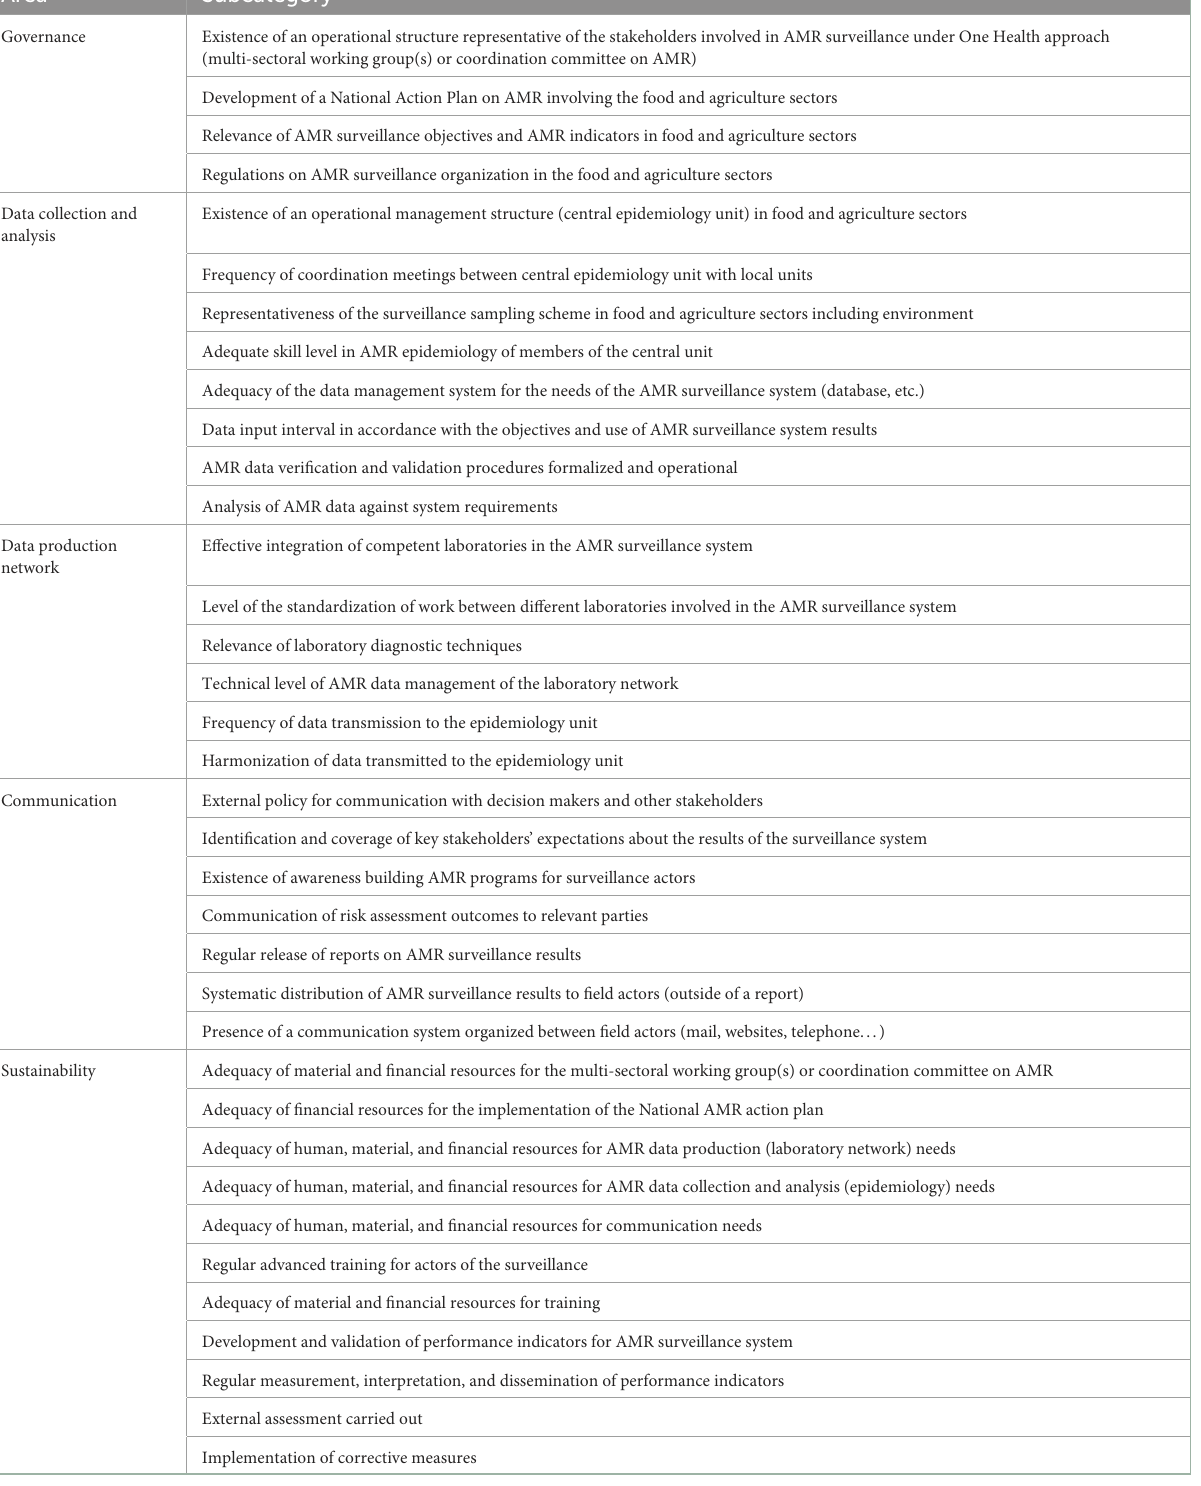
TABLE 1 Information collected in FAO-ATLASS SET-AMR questionnaire.